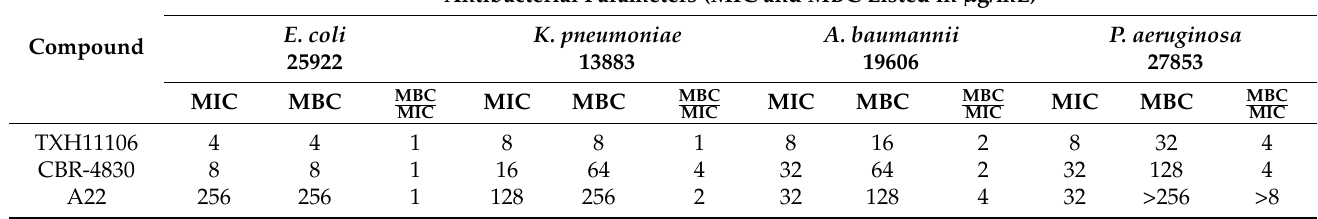
Table 1. Activity of TXH11106 and comparator MreB inhibitors against the Gram-negative pathogens E. coli , K. pneumoniae , A. baumannii , and P. aeruginosa . Antibacterial Parameters (MIC and MBC Listed in µ